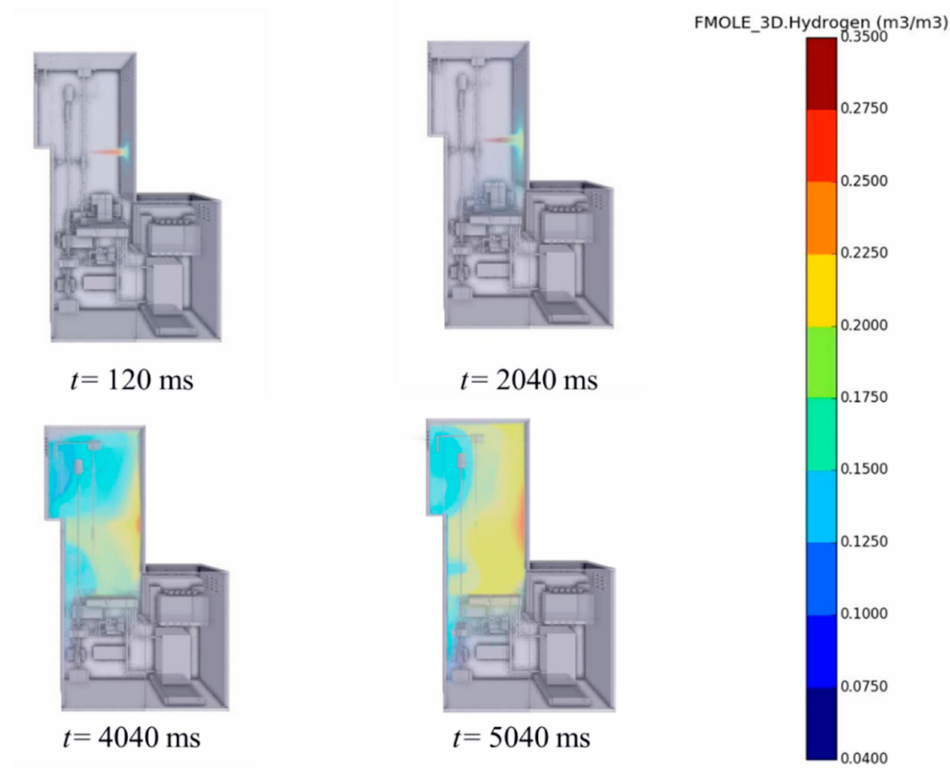
Figure 5. Volume fraction of hydrogen of Case